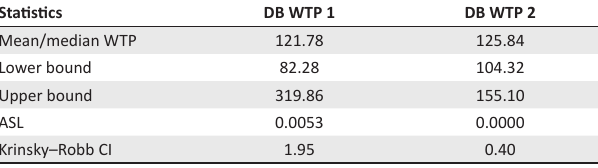
TABLE 8: Mean/median willingness to pay the